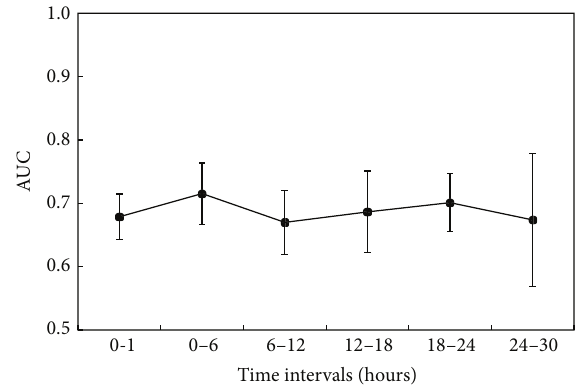
Figure 4: Variation of AUC using different, nonoverlapping, 6-hour intervals during the first 30 hours after ICU